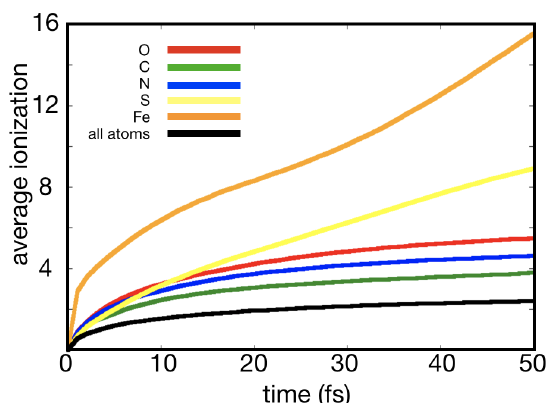
Figure 1. Average number of electrons lost in a Photosystem I (PSI) crystal vs. time. Data shown are simulated using the plasma code CRETIN, as described in [12]; input and output files are available in the Supplementary Materials. The PSI crystal has the relative atomic content of H 141400 O 57300 C 16900 N 3310 S 89 Fe 12 Mg 96 P 3 Ca , corresponding to a crystal containing 78% solvent water and a density of 1.077 g/cm 3 . The simulations were done with parameters corresponding to what can be expected at an XFEL source—pulse duration: 50 fs, photon energy: 10 keV, radiant fluece: 10 6 J/cm 2 . The figure clearly shows how iron and sulfur reach much higher ionization states, which lead to so-called hot spots in the protein